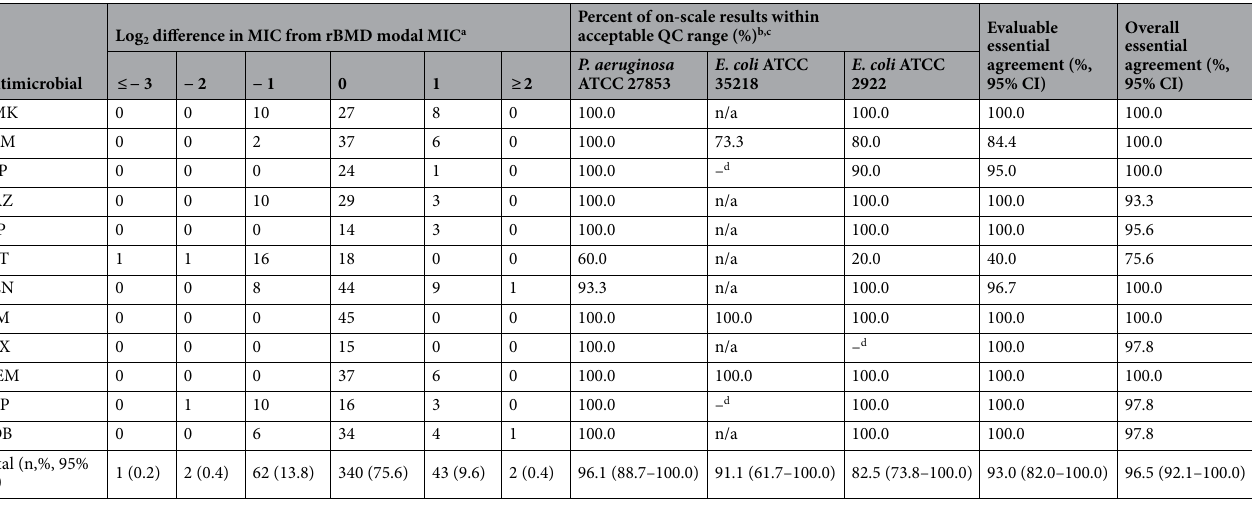
Table 2. Reproducibility of D300e dispensed AST panels assessed with 3 quality control strains. a Modal MIC values were calculated as the mode of all on-scale rBMD measurements for each antimicrobial-organism combination. b Quality control MIC ranges for each control organism were determined using the CLSI M100 MIC ranges for nonfastidious QC for both non-β-lactam combination and β-lactam combination agents 3 . c Organisms without QC ranges provided by CLSI for a particular antimicrobial are listed as n/a. d Organism- antimicrobial combinations that did not generate on-scale MIC results within the QC range are listed as